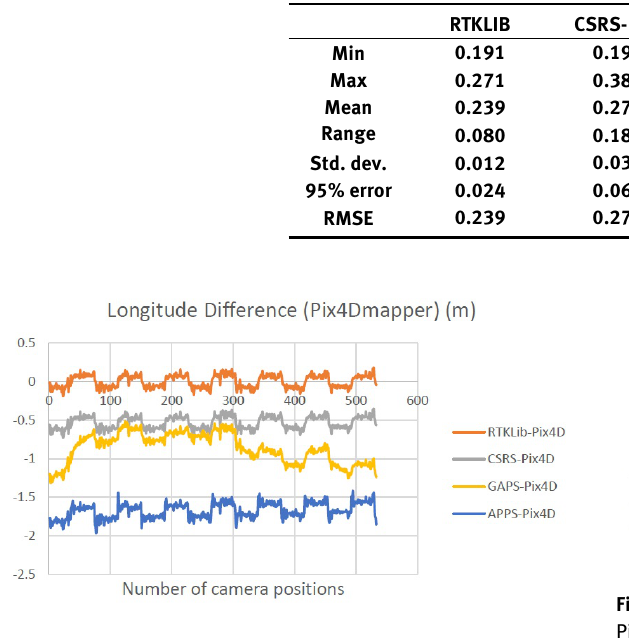
Fig. 13. Longitude differences between the coordinates produced by Pix4Dmapper and the software utilized in this project.